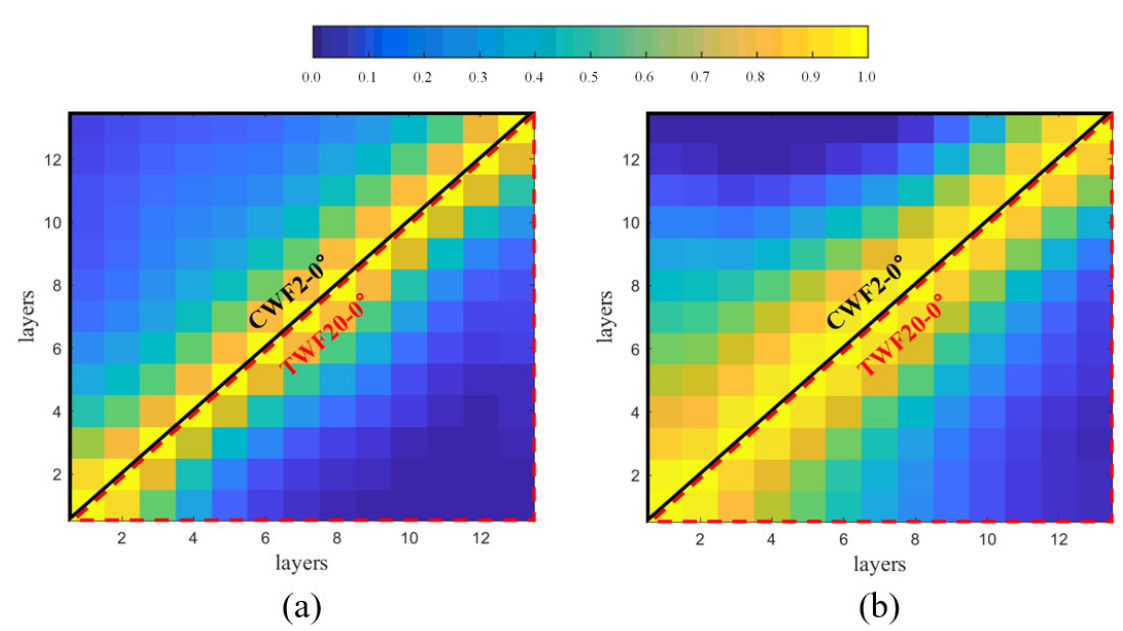
Figure 19. Correlation coefficients of ( a ) along-wind load and ( b ) across-wind load among different layers in the case of θ ref = 0°.